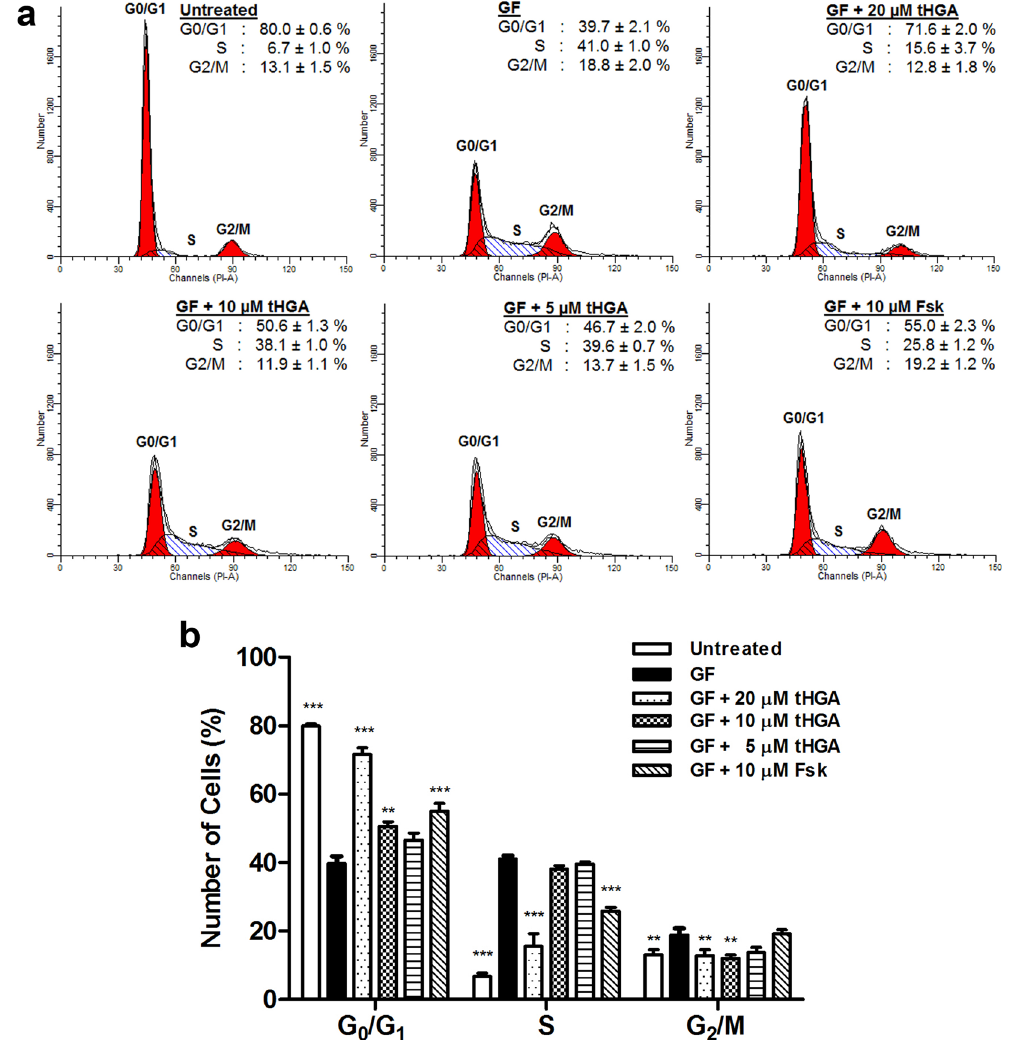
Figure 2. tHGA arrests growth factor-induced hBSMCs proliferation at G 0 /G 1 phase. hBSMCs were induced with growth factors and co-treated with tHGA or forskolin for 48 hours. ( a ) Representative histograms of cell cycle analysis on growth factor-induced hBSMCs upon tHGA or forskolin treatment. ( b ) Percentages of hBSMCs in different cell cycle stages following indicated